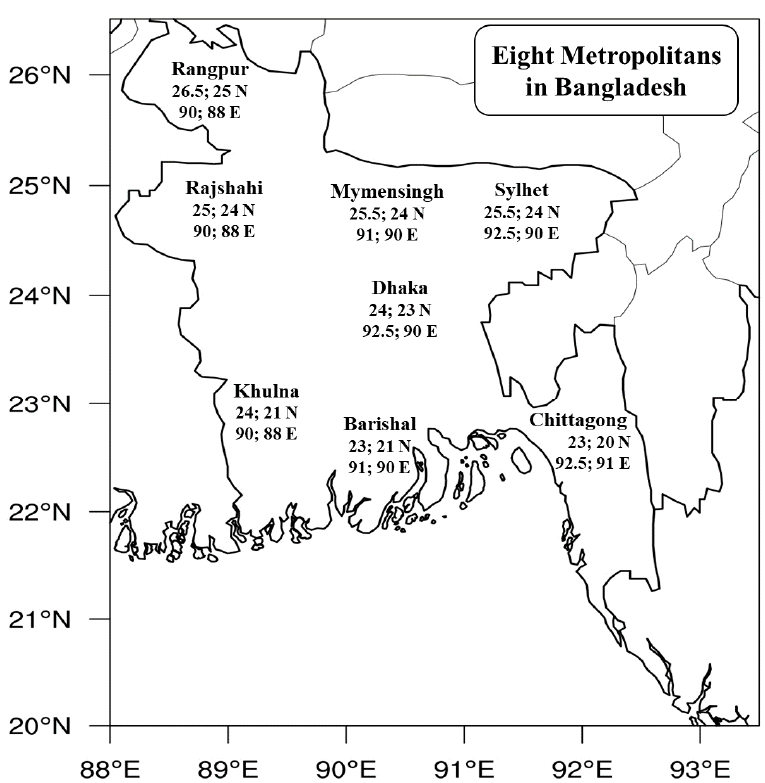
Figure 1. Study site: eight divisions and major cities in Bangladesh with coordinates for sub-do- mains.